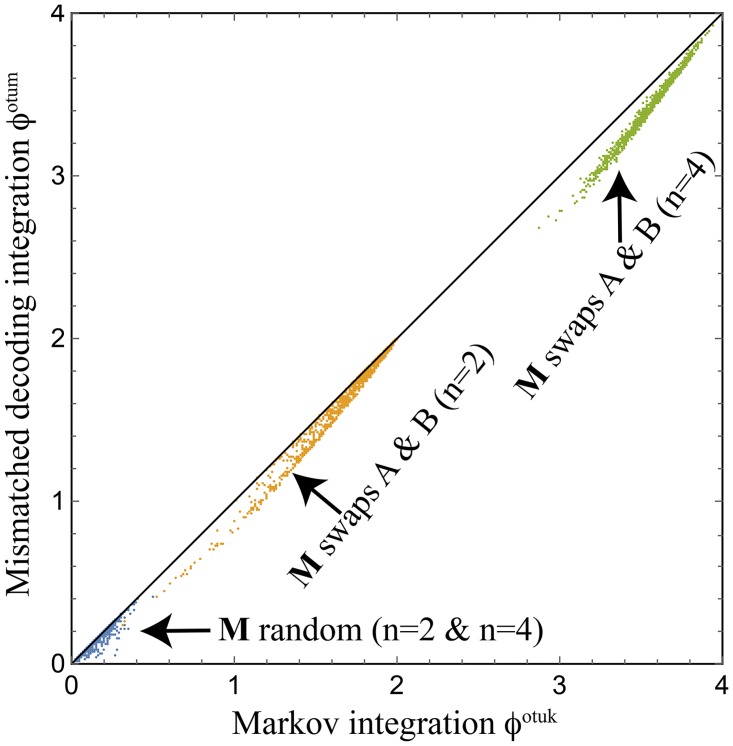
Numerical comparison of the two measures ϕotuk and ϕofum for 3,000 random trials, generated the same way as in Fig 2.The two measures are seen to be rather similar for these examples, and to satisfy the inequality ϕofum ≤ ϕotuk.